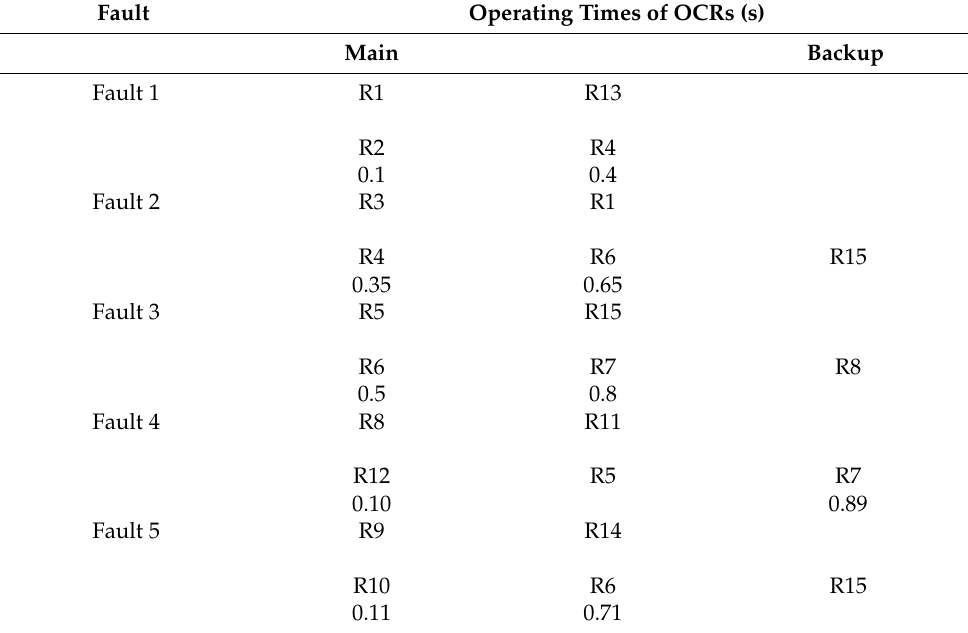
Table 4. Operating times for Scenario